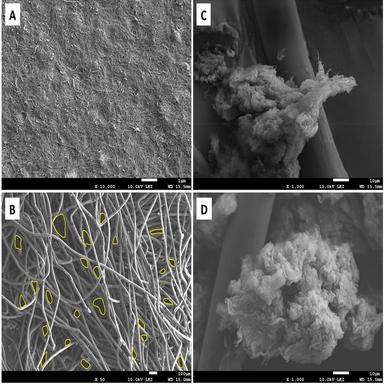
SEM image of CNT/CNC nanocomposite buckypaper. (For interpretation of the references to color in this figure, the reader is referred to the web version of this article.)